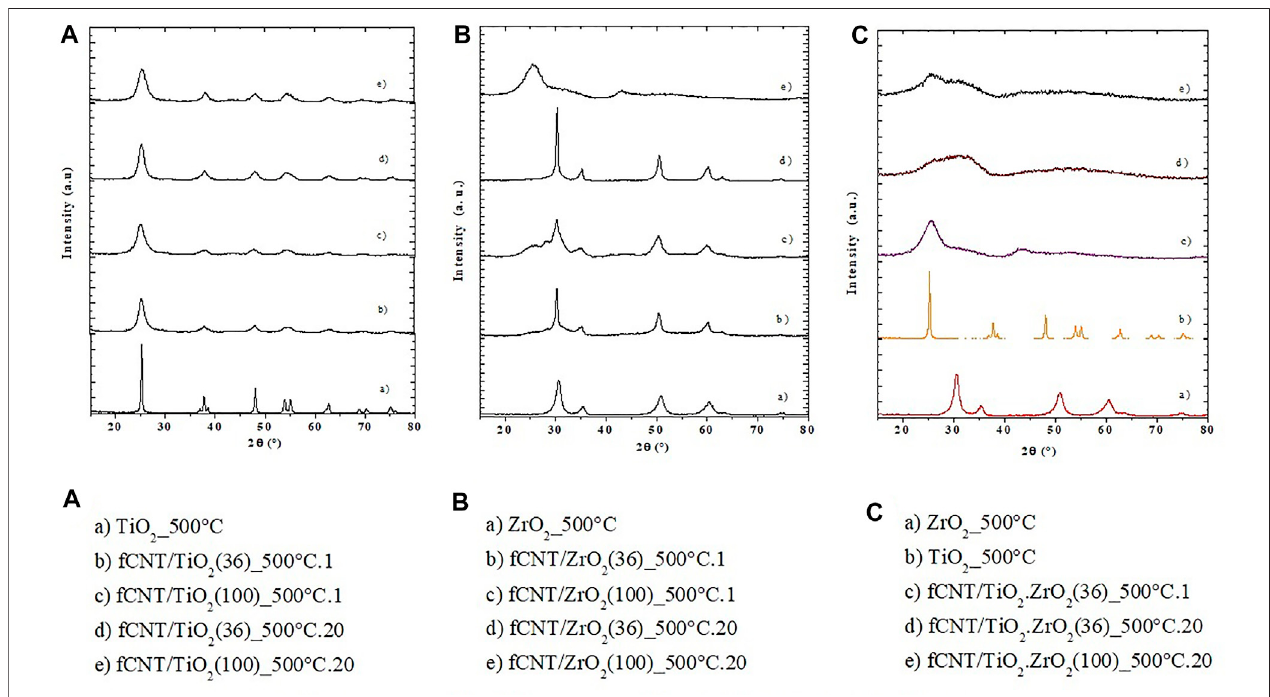
FIGURE 2 | XRD patterns of the different materials: (A) TiO 2 ; (B) ZrO 2 ; (C) TiO 2 .ZrO 2 .